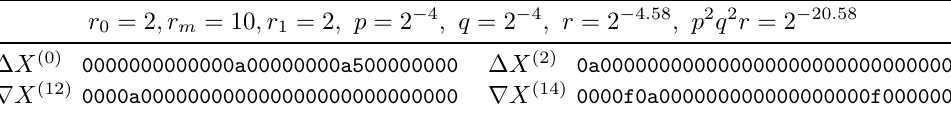
Table 3: 14-round sandwich distinguisher for WARP